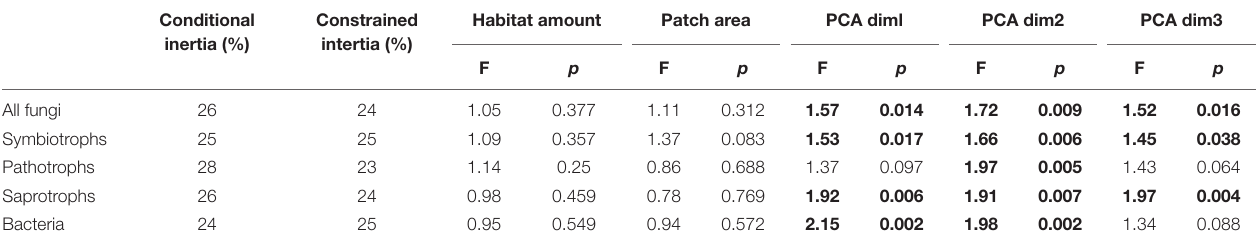
TABLE 3 | Results from distance-based redundancy analysis (db-RDA) using Bray-Curtis dissimilarity. Conditional Constrained inertia (%) intertia (%)